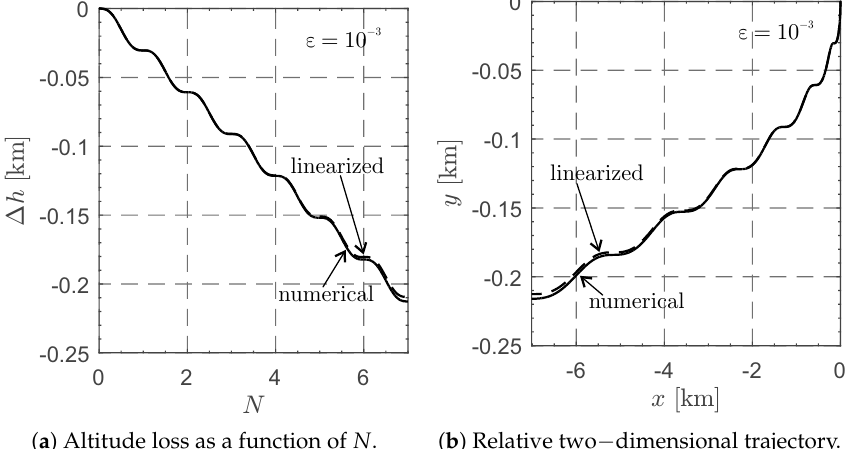
( b ) Relative two − dimensional trajectory. Figure 6. Comparison between the numerical (solid line) and linearized (dashed line) solutions when a T 0 = 0.0024mm/s 2 , h 0 = 1000km, and (cid:101) = 10 − 3